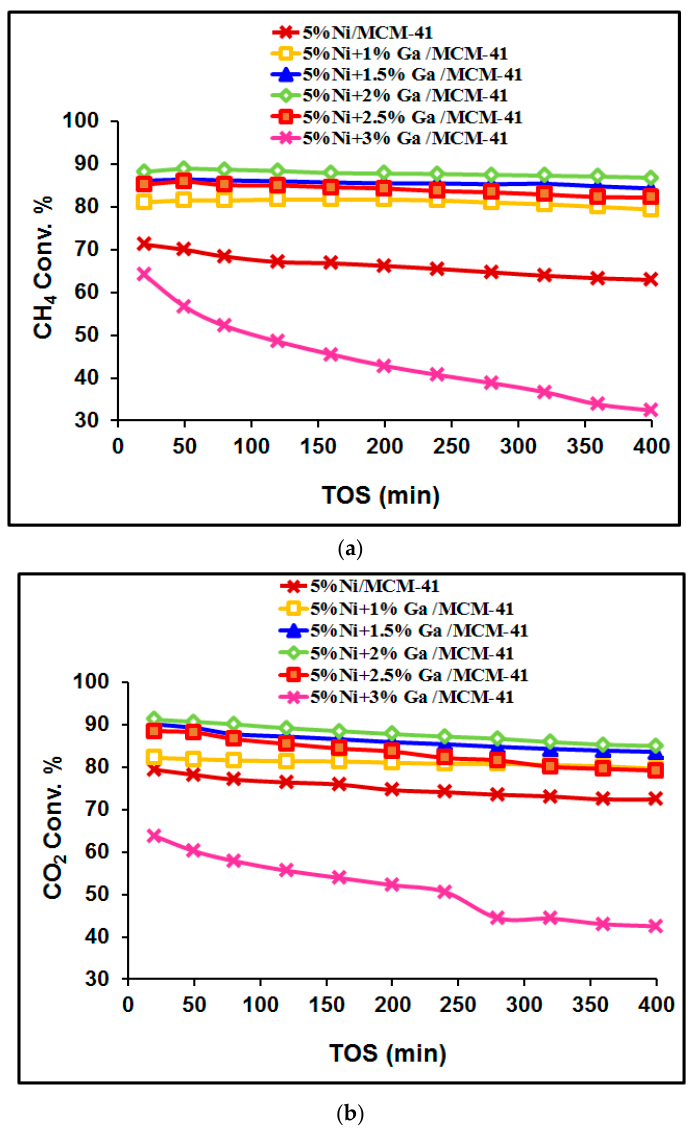
Figure 7. Graph of the ( a ) CO 2 conversion and H 2 /CO ratio and ( b ) CH 4 conversion with time over different nickel based catalysts at reaction temperature of 800 °C, at atmospheric pressure, CH 4 :CO 2 = 1:1 in the feed gas, catalyst weight: 0.1 g, WHSV: 21,000 mL g − 1 h − 1 .